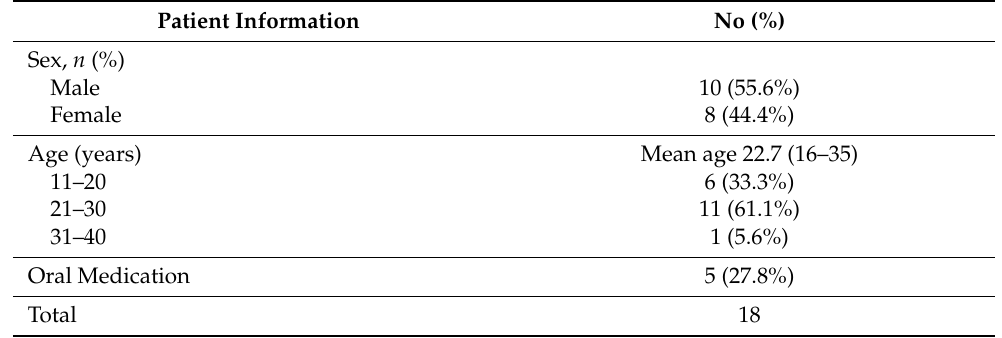
Table 1. Demographic data of acne vulgaris patients.